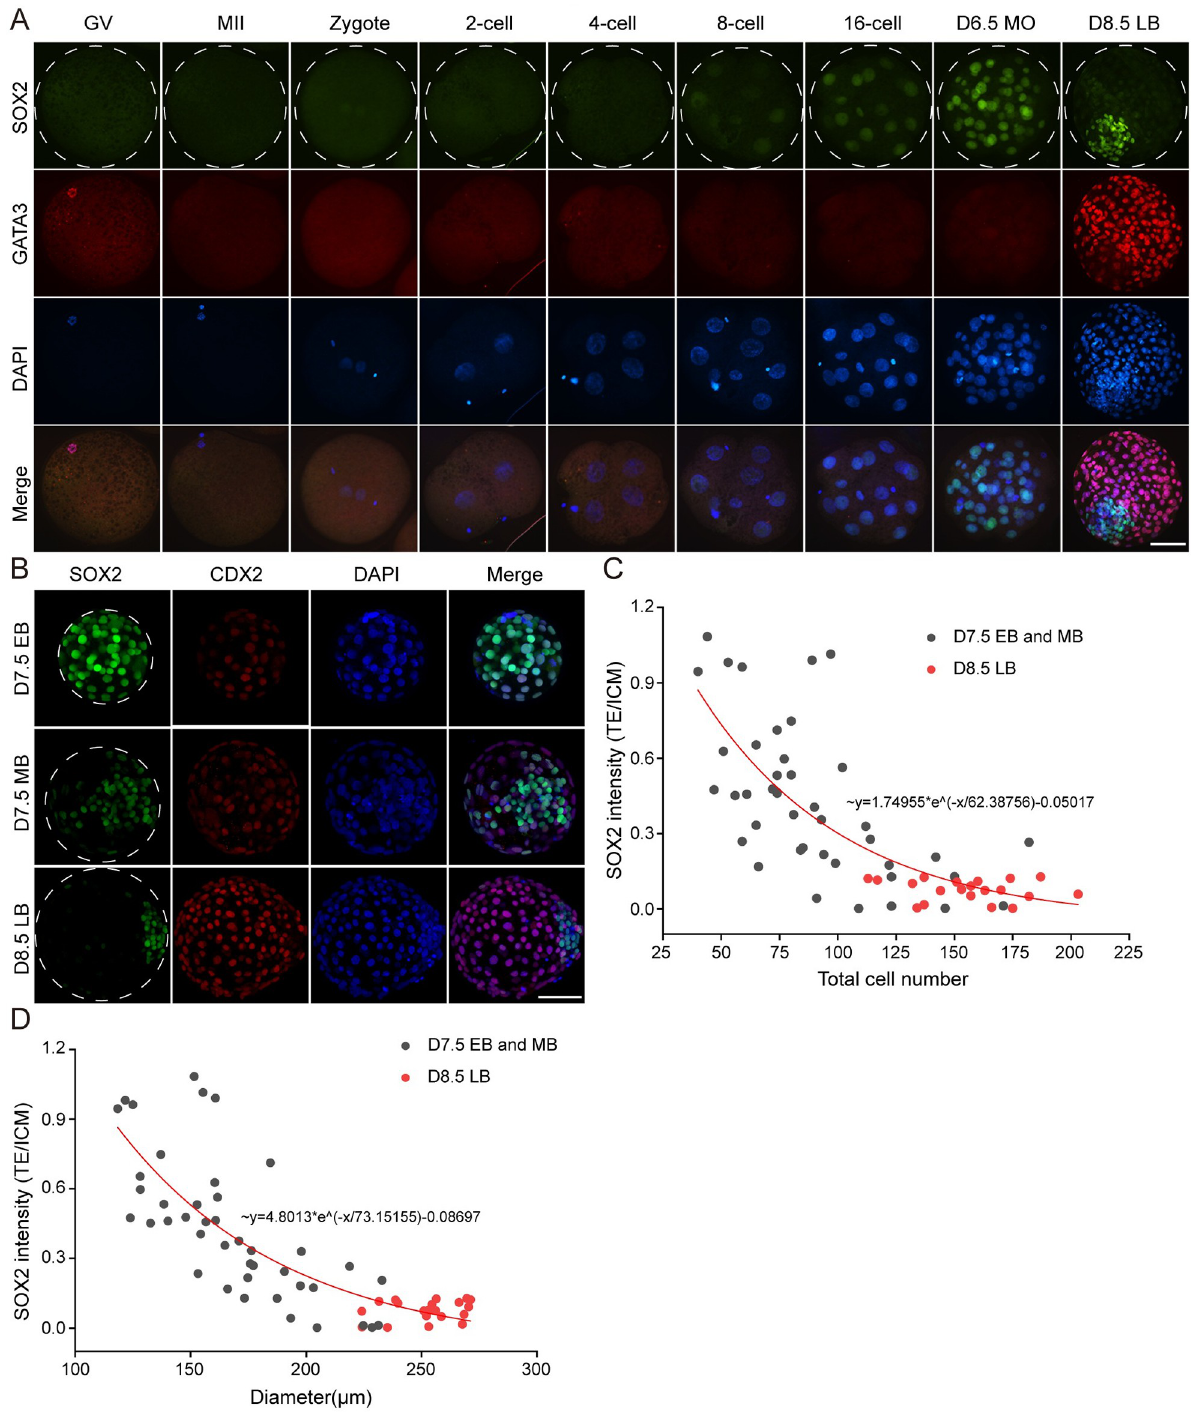
Fig 2. Dynamic expression pattern of SOX2 during bovine early embryonic development. A. Immunofluorescence detection of SOX2 and GATA3 during oocyte maturation and embryonic development. Green: SOX2 protein; Red: GATA3 protein; Blue: DAPI (Nuclei). The experiment was independently replicated two times with at least 10 oocytes or embryos per stage analyzed. Scale bar = 50 μ m. GV: germinal vesicle, MII: metaphase II, D6.5 MO: D6.5 morula, D8.5 LB: D8.5 late blastocysts. B. Immunofluorescence analysis of SOX2 protein along with blastocyst expansion. Green: SOX2; Red: CDX2; Scale bar = 50 μ m. D7.5 EB: D7.5 early blastocyst, D7.5 MB: D7.5 middle blastocyst, D8.5 LB: D8.5 late blastocyst. C and D: The correlation between SOX2 intensity (TE/ICM) and total cell number or diameter. Note: the red bullets represent D8.5 late blastocysts.